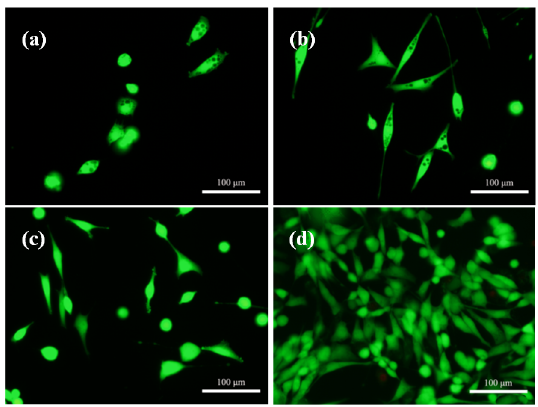
Figure 12. Fluorescent images of cells cultured on the CaSO 4 scaffolds with: ( a ) 0 wt % (control) and ( c ) 5 wt % 45S5 bioglass for one day; ( b ) 0 wt % (control) and ( d ) 5 wt % 45S5 bioglass for three days.